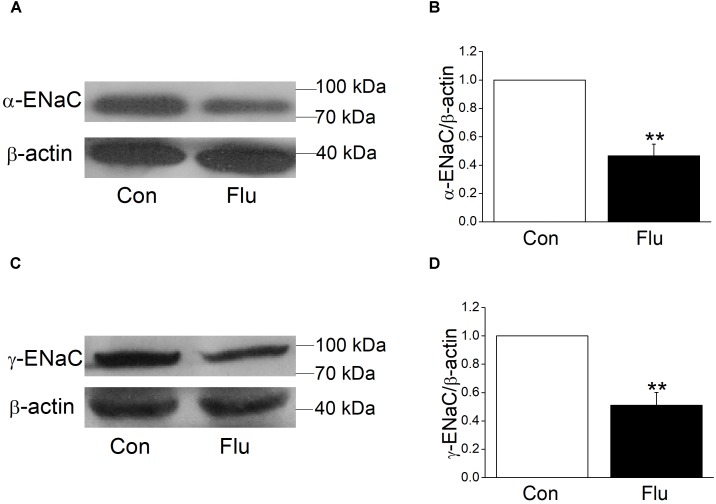
Effects of influenza on the protein expression level of α- and γ-ENaC subunits in MTECs. MTECs were infected to influenza virus (Flu) for 24 h and then proteins were extracted and analyzed by western blot. (A,C) Western blot bands of α- and γ-ENaC subunits demonstrating reductions in protein levels. Blots for β-actin were used as internal controls. (B,D) Graphical representation of data obtained from western blot assays for α- and γ-ENaC subunits, which were quantified using gray analysis (α-ENaC/β-actin and γ-ENaC/β-actin), ∗∗P < 0.01, compared with control (Con), n = 3–4. Data was presented as mean ± SE Student’s t-test was used to analyze the difference of the means for significance.